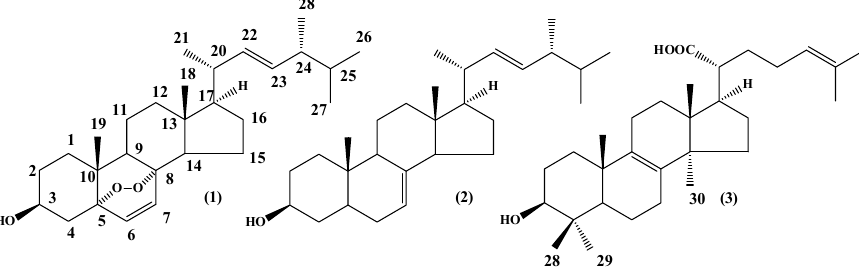
Figure 1. Chemical structure of sterols isolated from Trametes versicolor fruiting body. Ergosterol peroxide 1 ; 7,22-ergostadien-3 β -ol 2 and trametenolic acid B 3 .